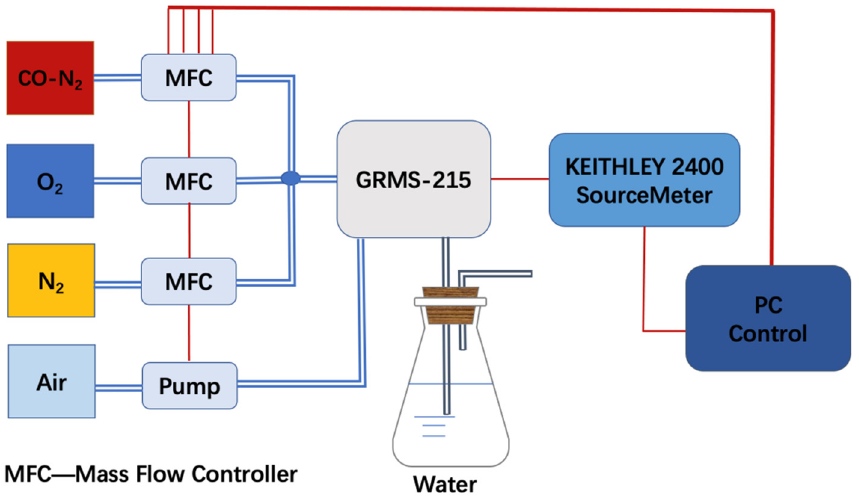
Figure 1. A scheme for CO-sensing measurement set-up.